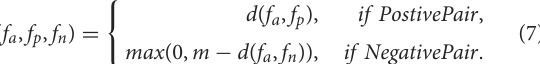
Where y i means the label of pixel i (1 and 0 means the keypoint and background, respectively), p i refers to the predicted probability of pixel i to be the